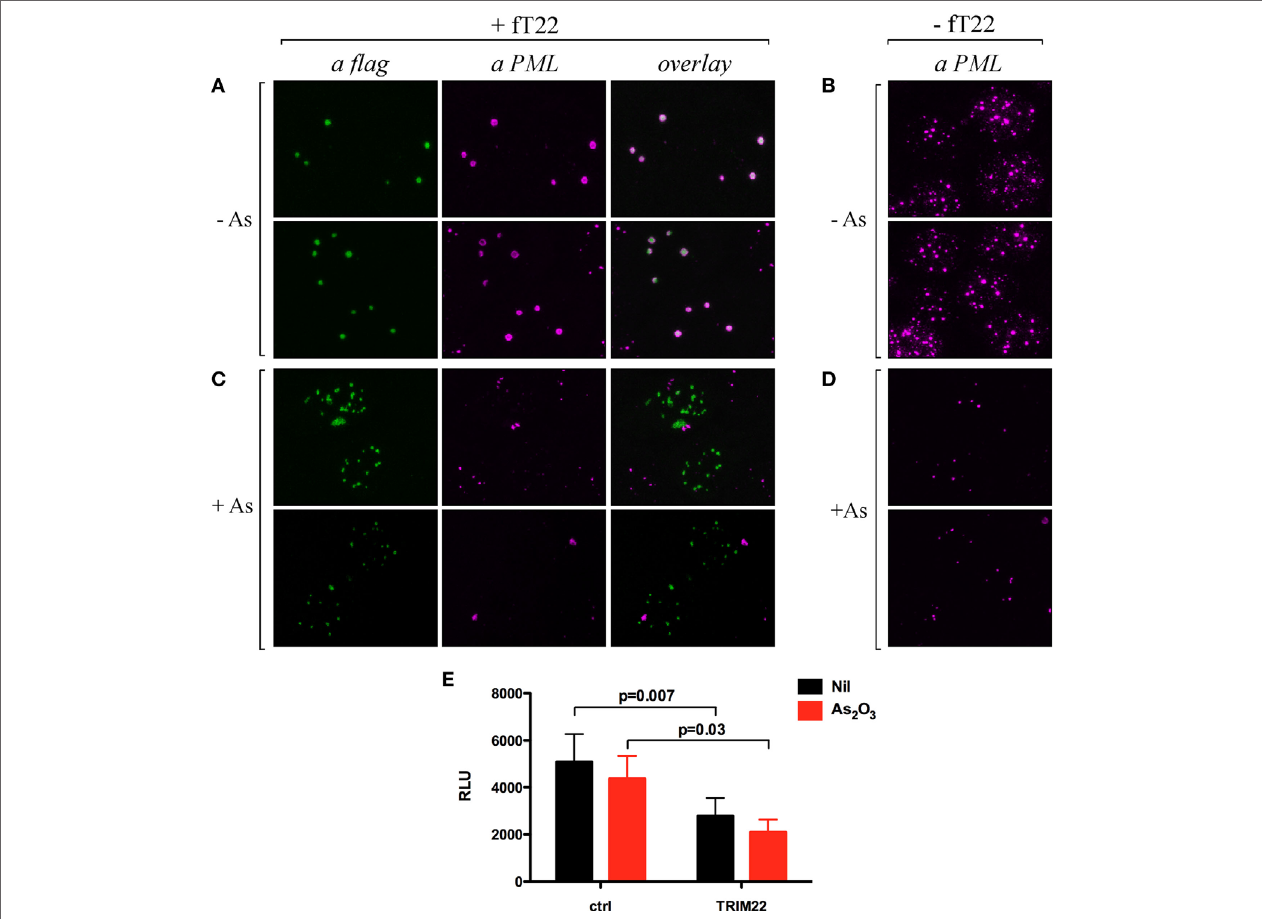
FigUre 5 | effect of arsenic treatment on tripartite motif-containing protein 22 (TriM22) and promyelocytic leukemia (PMl) cellular distribution in hep-2 cells . Hep-2 cells transfected with fTRIM22 (a,c) or with empty vectors (B,D) were exposed to 1 mM arsenic trioxide ( + As) (c,D) or to vehicle ( − As) (a,B) for 8 h. Cells were analyzed by immunofluorescence and confocal microscopy by using the anti-PML mouse monoclonal antibody followed by goat anti-mouse AlexaFluor 546-conjugated antibody. Flag-TRIM22 was detected by direct staining with fluorescein isothiocyanate-conjugated anti-flag antibody. (e) 293T cells were transfected with a Luciferase reporter under the control of HIV-LTR and a TRIM22 expressing plasmid in a ratio 1:10, respectively, with and without